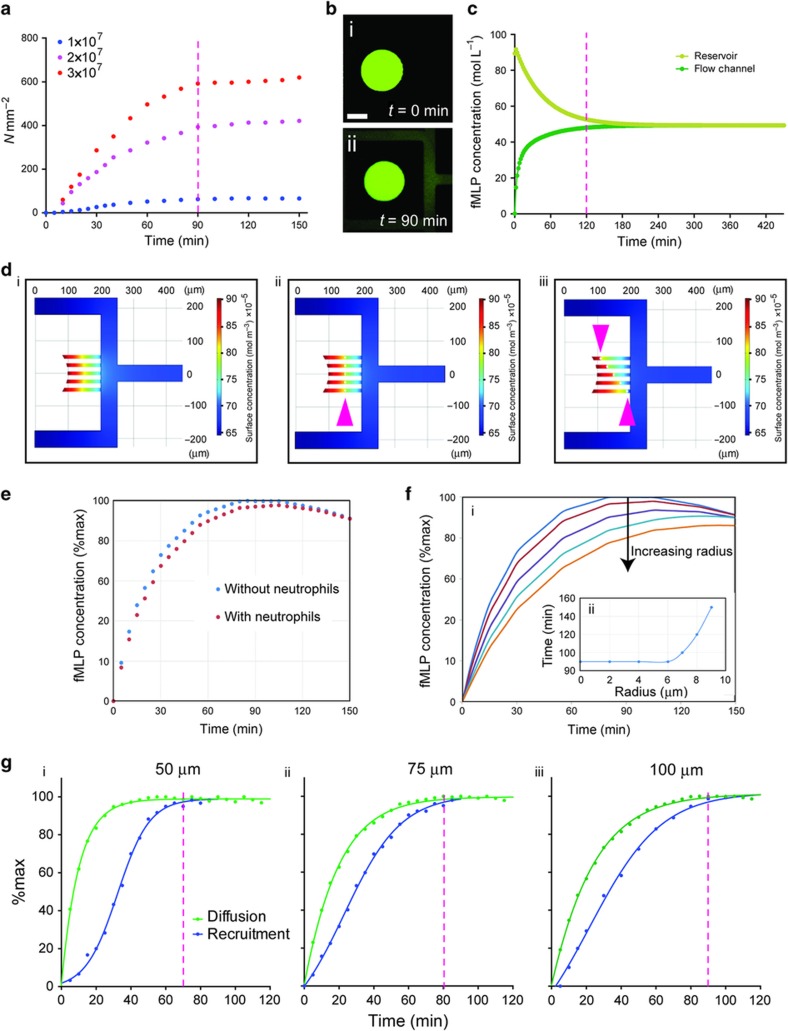
Cessation of neutrophil recruitment correlates to the ‘stabilization’ of the chemoattractant gradient. (a) Plot of the neutrophil recruitment with time for three different cell-loading densities. Stabilization of neutrophil recruitment was observed at 90 min for all cell densities (dashed magenta line). (N=3). (b) Images of the neutrophil reservoir (i) before and (ii) after the fluorescence diffusion from the chemo reservoir into the flow channel. (c) Finite element modeling of the concentration in the reservoir and channel over time. The difference between the two concentrations is 100 pM at ~120 min (dashed magenta line). (d) Finite element modeling of the surface plot for chemoattractant concentration distribution in the flow channel as modeled using COMSOL v4.3b. Gradients are modeled in absence (i) and presence (ii, iii) of cells occluding the channels. (e) Modeling of the effect of neutrophil presence on formyl-methionyl leucyl-phenylalanine (fMLP) diffusion over time. (f) Modeling the effect of cell size on fMLP diffusion as measured by fMLP concentration in the flow channel ((i) colored lines show diffusion in the presence of cells with radius sizes of 4, 6, 7, 8, and 9 μm) demonstrates that channel occlusion by cells with a radius >6 μm may affect fMLP diffusion (ii). (g) Comparison of the time for neutrophil recruitment plateau and diffusion in the 50 μm (i), 75 μm (ii), and 100 μm (iii) long connecting channels. The time of chemoattractant gradient ‘stabilization’ matched the cessation of neutrophil recruitment for each channel length (dashed magenta lines).